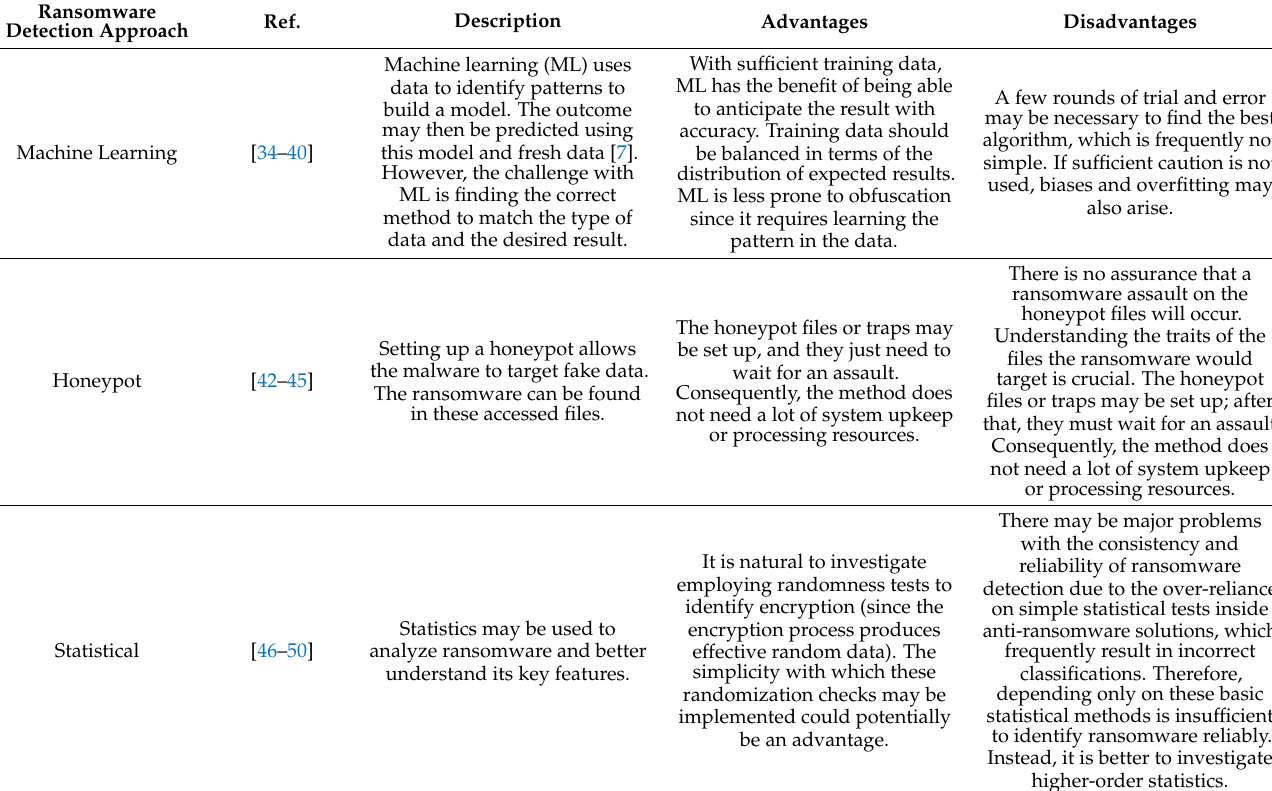
Table 6. Comparison between ransomware detection